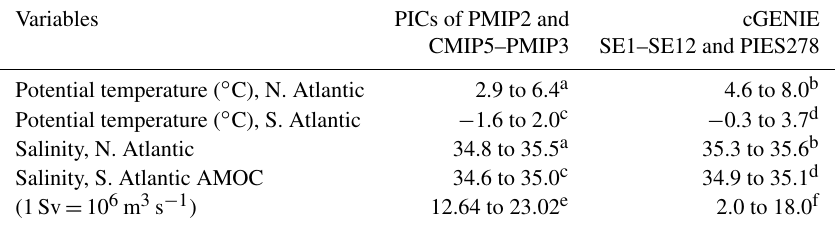
Table 2. Diagnostic variables of the pre-industrial control states (PICs) of PMIP2 and CMIP5–PMIP3 (temperature and salinity as read from Fig. 9.18. of WG1 in IPCC AR5 and AMOC as given in Table 1 in Muglia and Schmittner, 2015) compared to similar diagnostics for our ensemble SE1–SE12 and control state